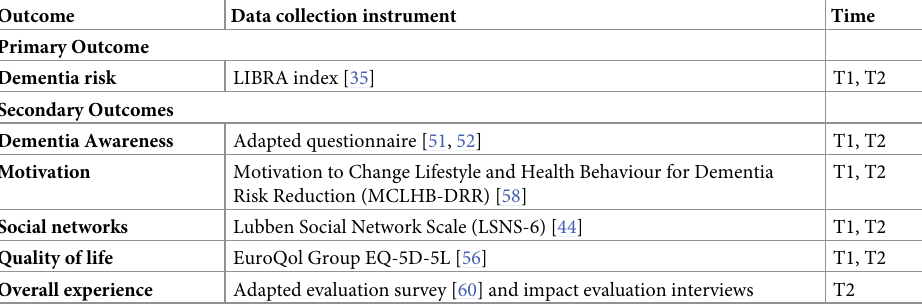
Table 1. Summary of outcomes and their